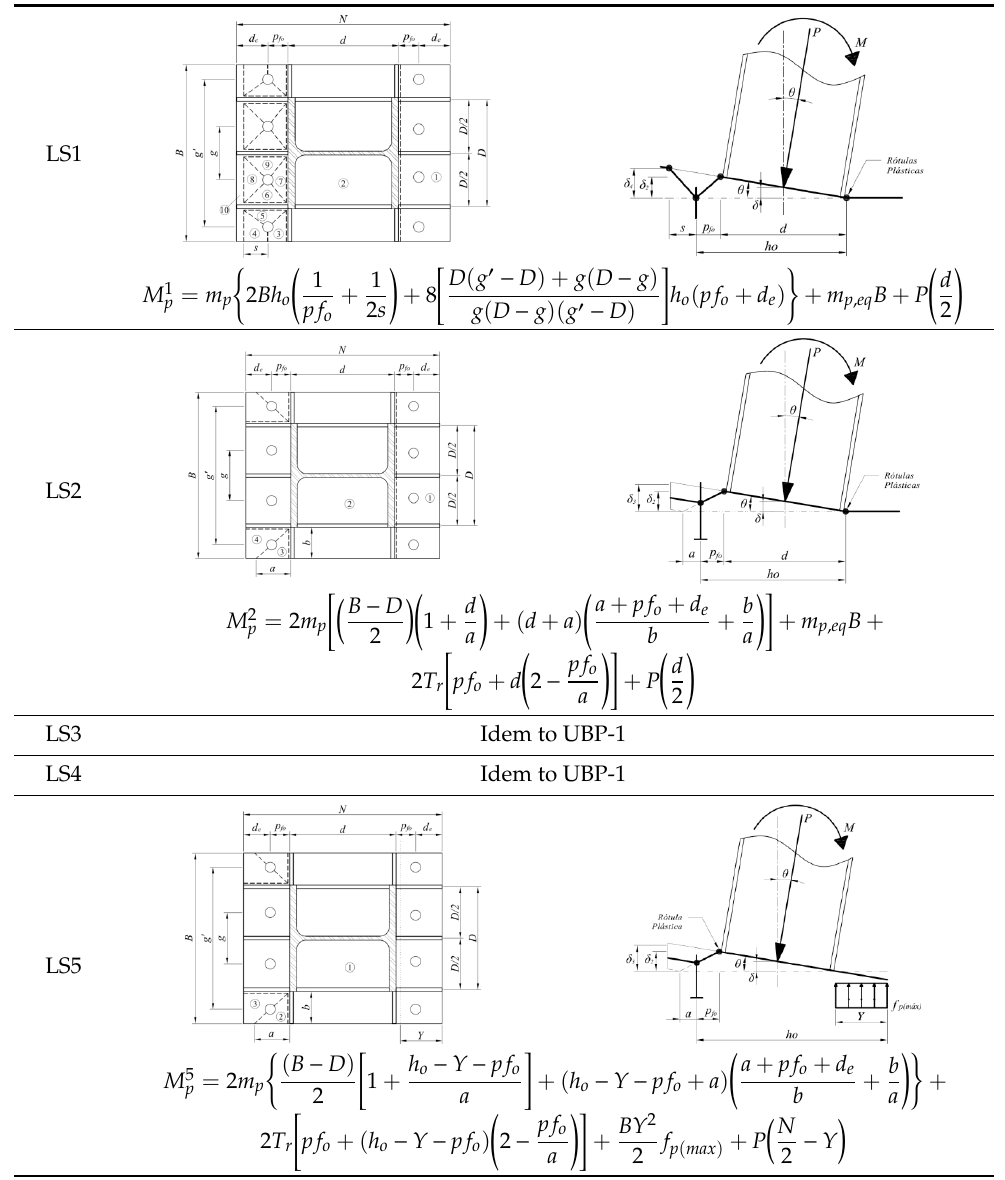
Table 5. Limit states that control the design of base plate type SBP-2.